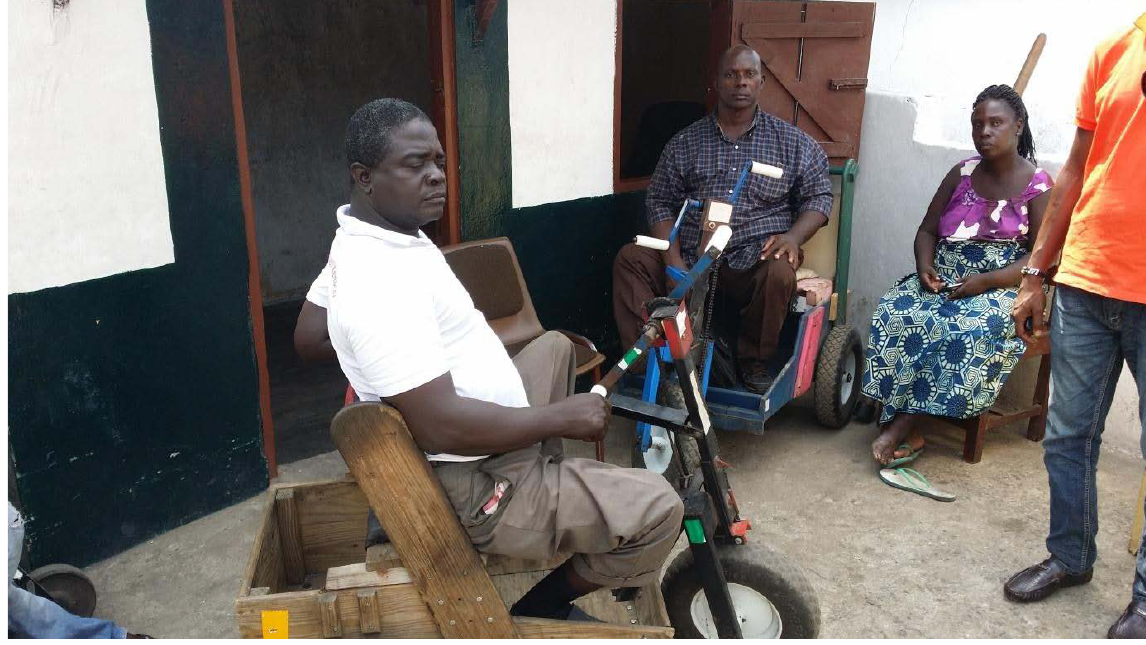
Figure 1. Disabled war combatants